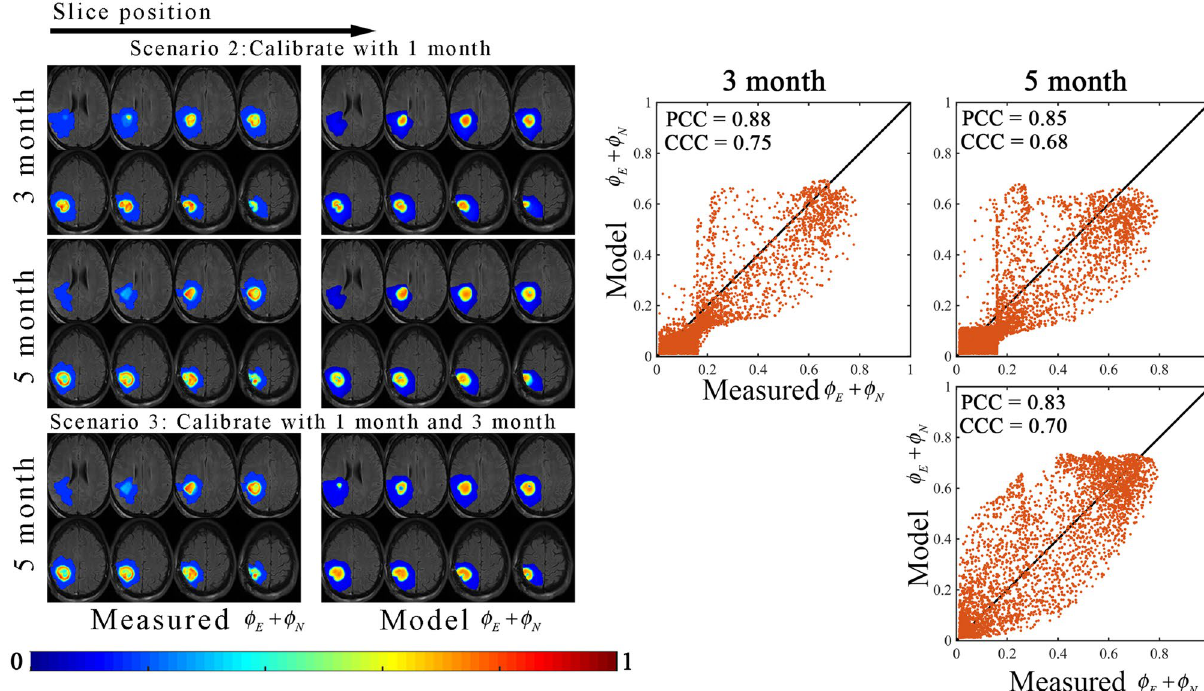
Figure 5. Representative results from scenarios 2 and 3. The central eight tumor slices from patient 2 are used to demonstrate the model calibration results using the best model as determined by the AIC. The measured and model determined sum of the enhancing and non-enhancing regions